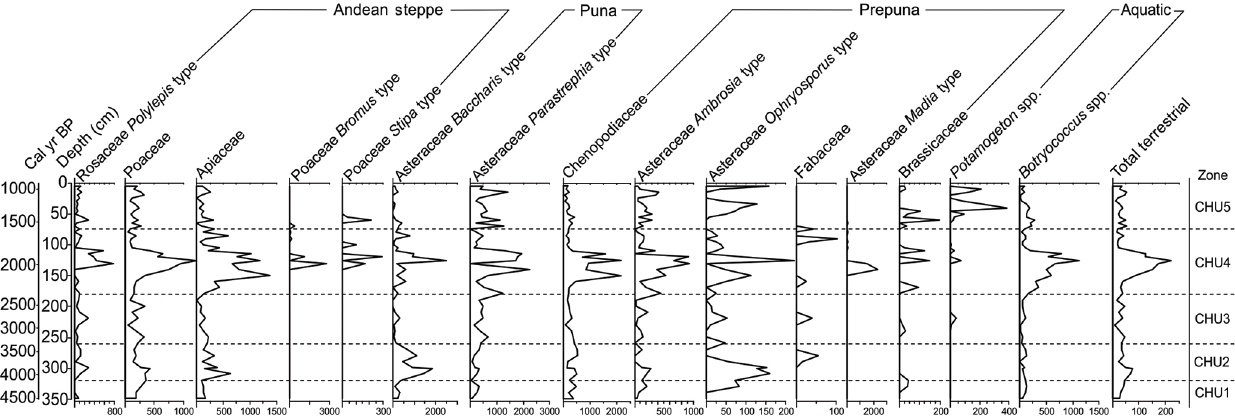
Figure 5. Terrestrial and aquatic pollen accumulation rate (PAR; grain cm − 2 yr − 1 ) of the Lago Chungará sediment section. PAR values are calculated using the depositional time obtained from the age–depth model published by Giralt et al.